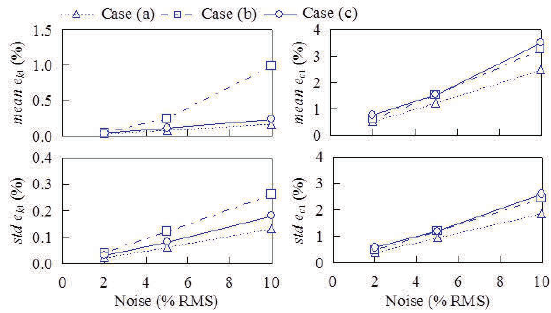
Figure 4. Means and standard deviations (std’s) of normal- ized estimation error of 1 st story using story-by-story ap- proach: Case (a): no noise on displacement and velocity; Case (b): noise on displacement and velocity; and Case (c): noise on displacement and acceleration processed by the Kalman data fusion.